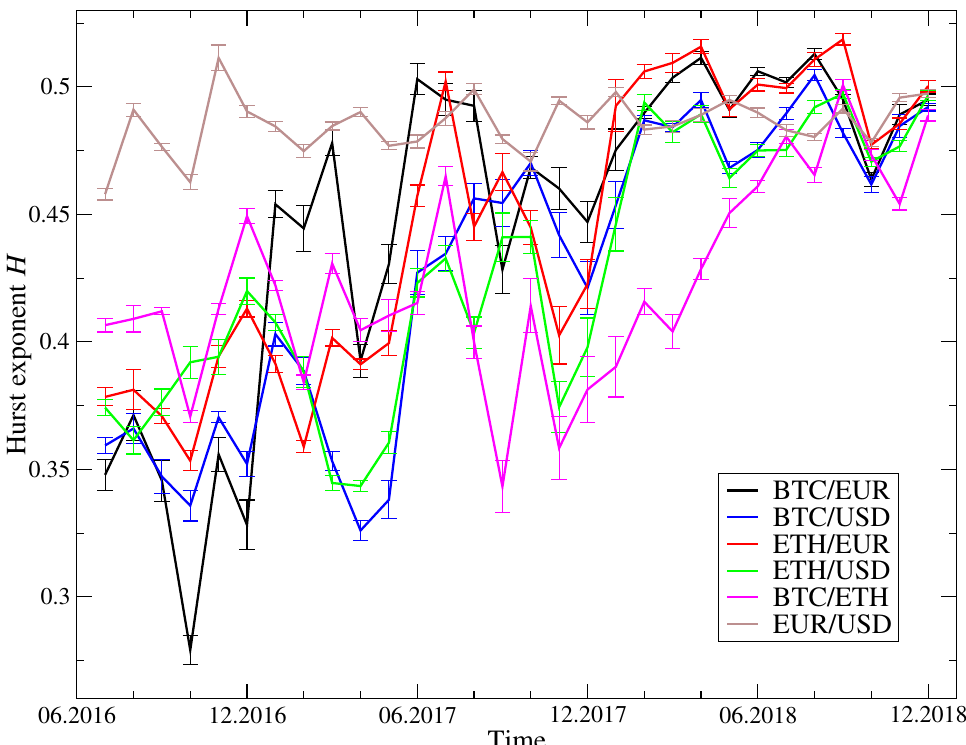
Figure 7. Hurst exponent H calculated over 30-days window for the BTC/EUR, BTC/USD, ETH/EUR, ETH/USD, BTC/ETH and EUR/USD exchange rates from 1 July 2016 to 31 December 2018. Error bars reflect the standard error of the regression